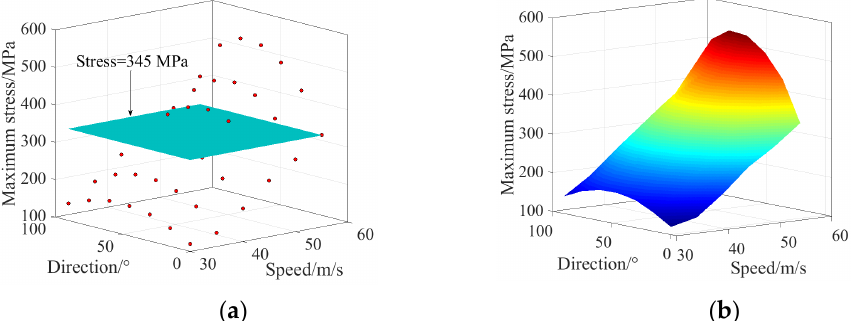
Figure 10. The instantaneous maximum stress: ( a ) Scatter plot; ( b ) Continuous plot.